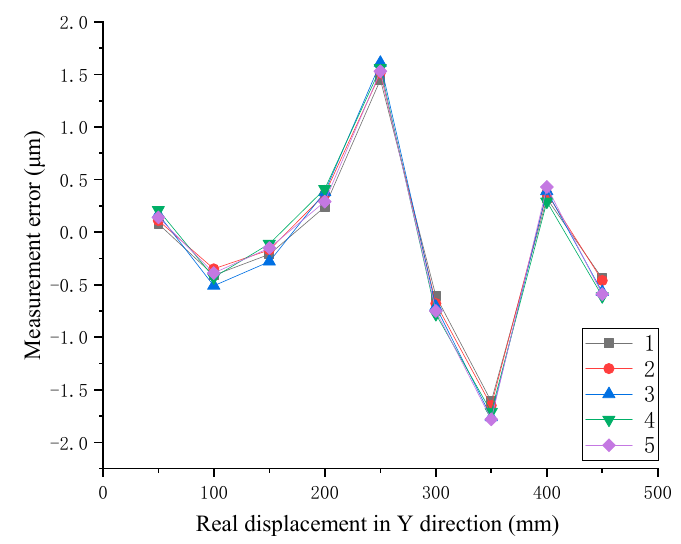
Figure 16. Measurement errors in the direction of Y.